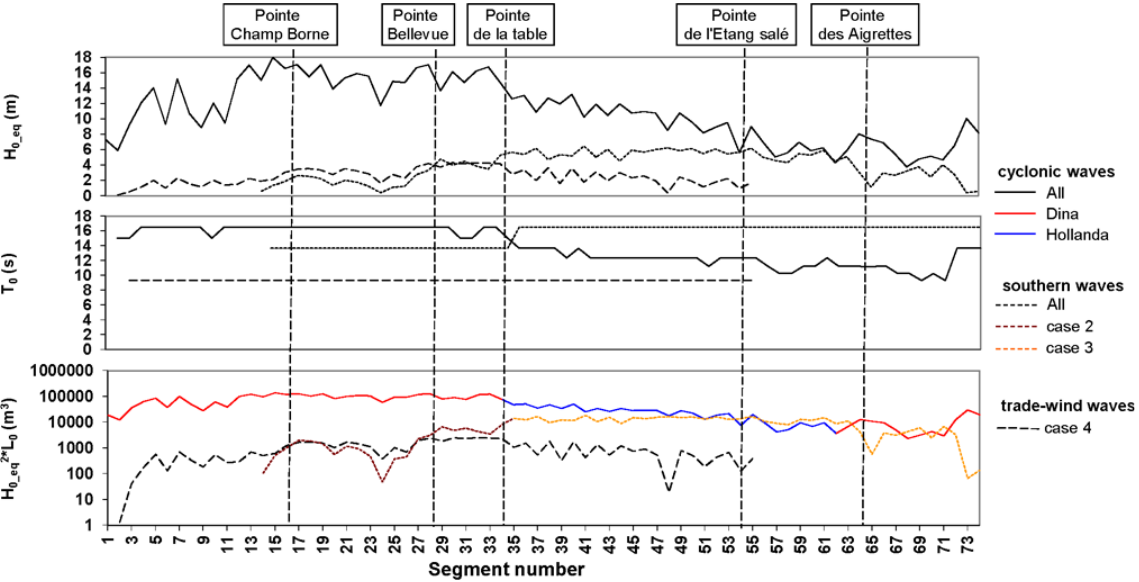
× L 0 ) obtained for each 0 eq